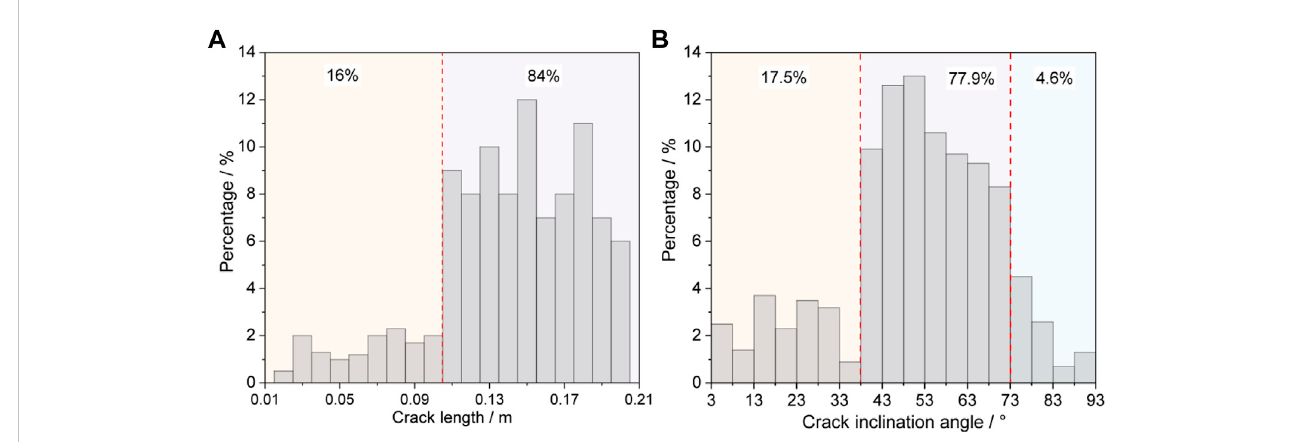
FIGURE 7 Distribution of cracks in the rock mass: (A) crack length and (B) crack inclination